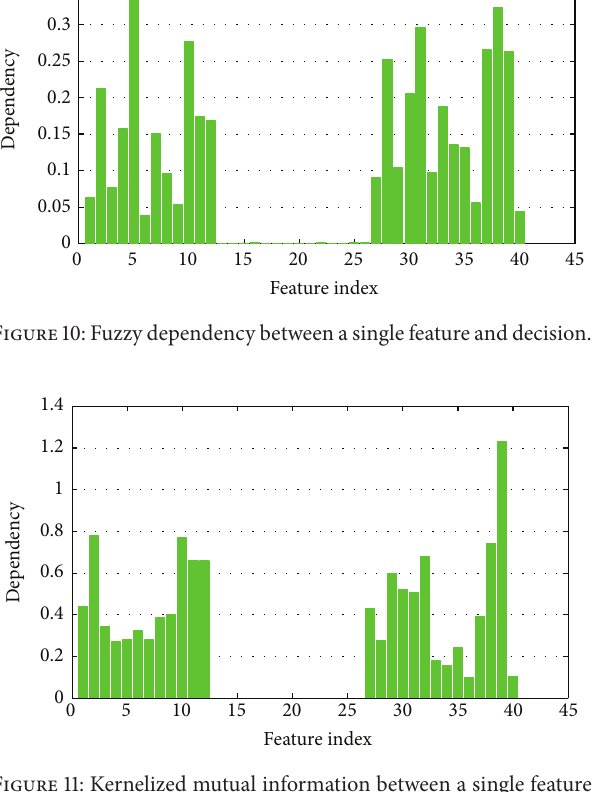
Figure 11: Kernelized mutual information between a single feature and decision.